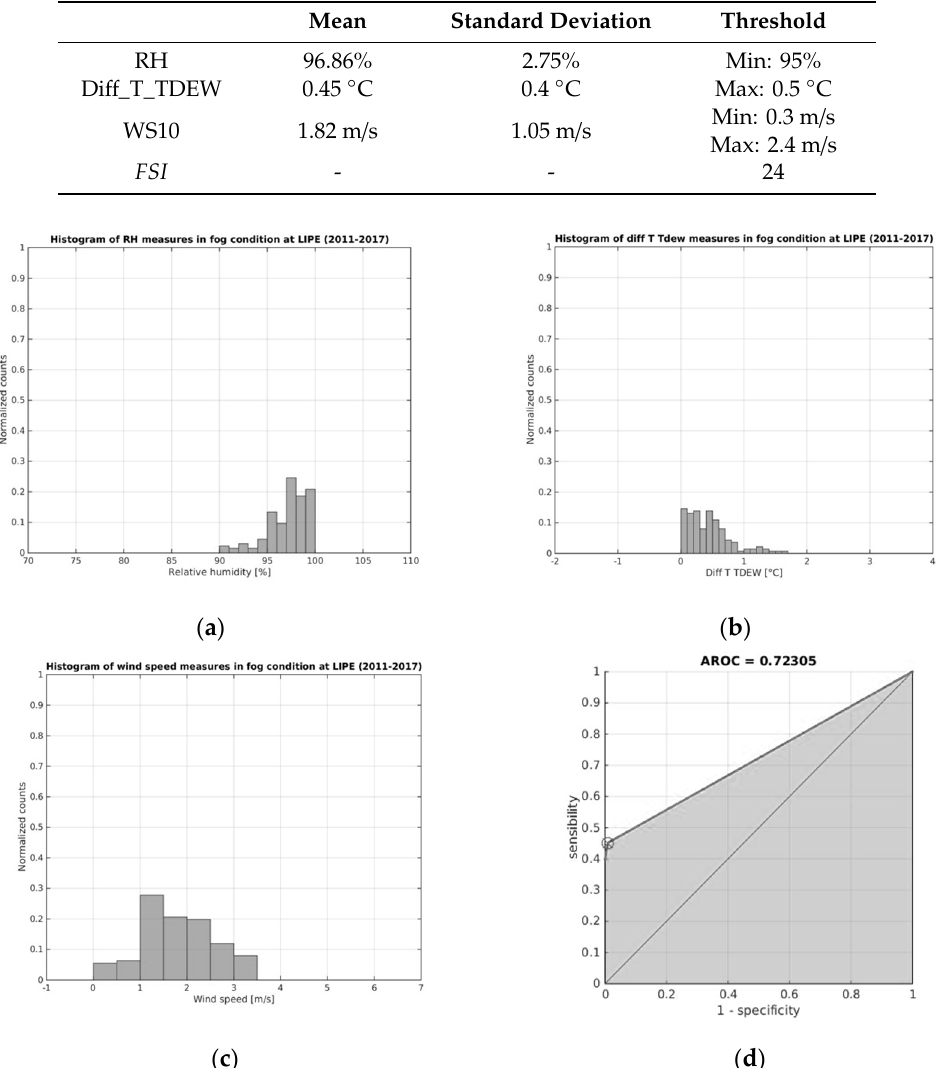
Figure 9. Histograms of the measurements of ( a ) relative humidity, ( b ) surface temperature / dew point